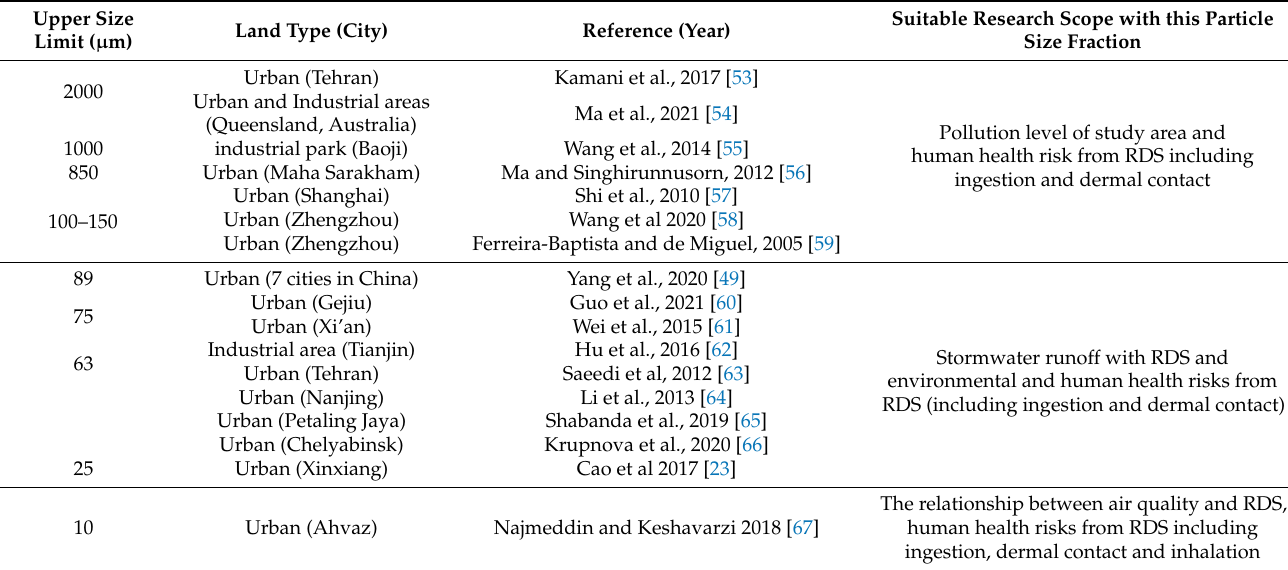
Table 1. Previous RDS studies in recent a decade which are dealt with the assessment of human health risk by RDS with pollutants, and the suitable research scope with its particle size